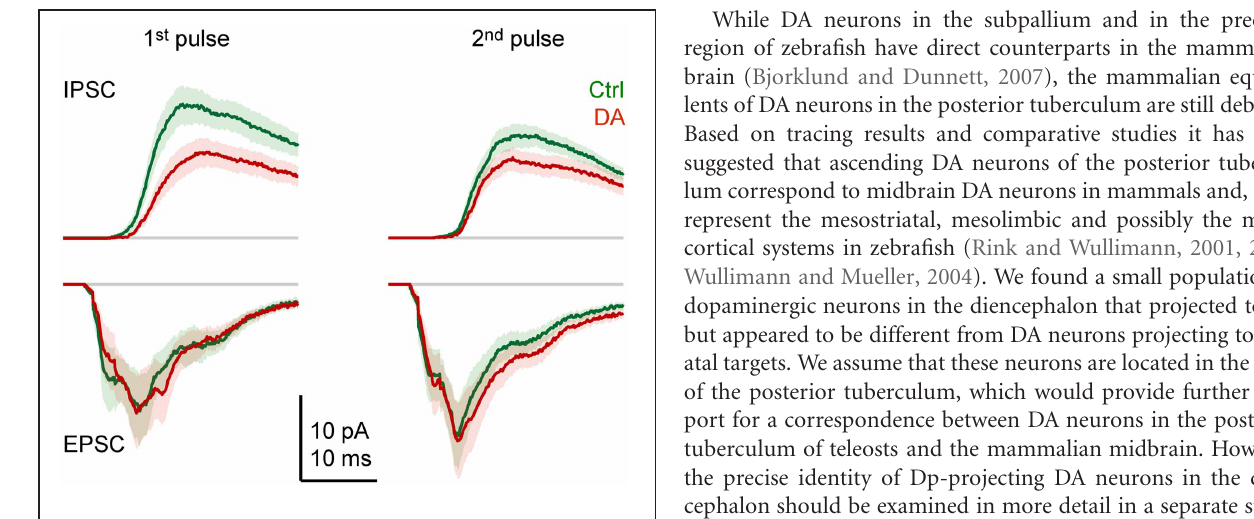
FIGURE 6 | Effects of DA on the time course of synaptic currents. EPSCs and IPSCs evoked by paired-pulse stimulation of the olfactory tract (inter-stimulus interval: 30ms) before (green) and during (red) bath-application of DA (50 µ M), averaged over Dp neurons ( n = 16 in 9 fish). Stimulus artifacts were removed. Lines show mean current; shading shows standard